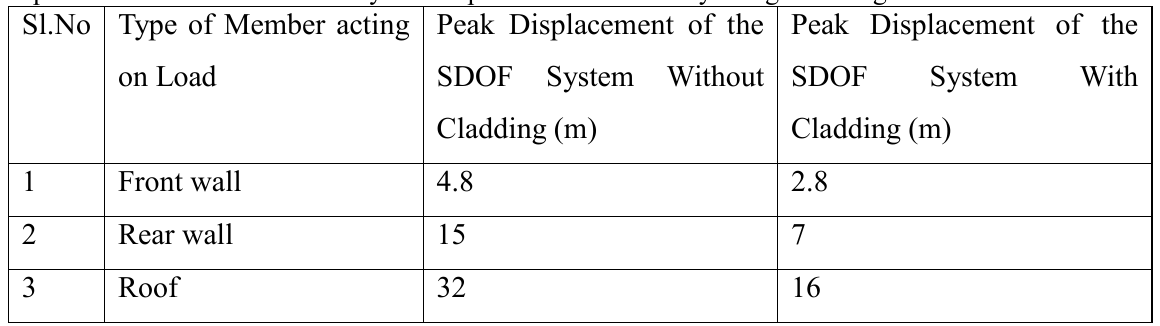
Displacment reduction of SDOF system exposed to Blast load by using Cladding